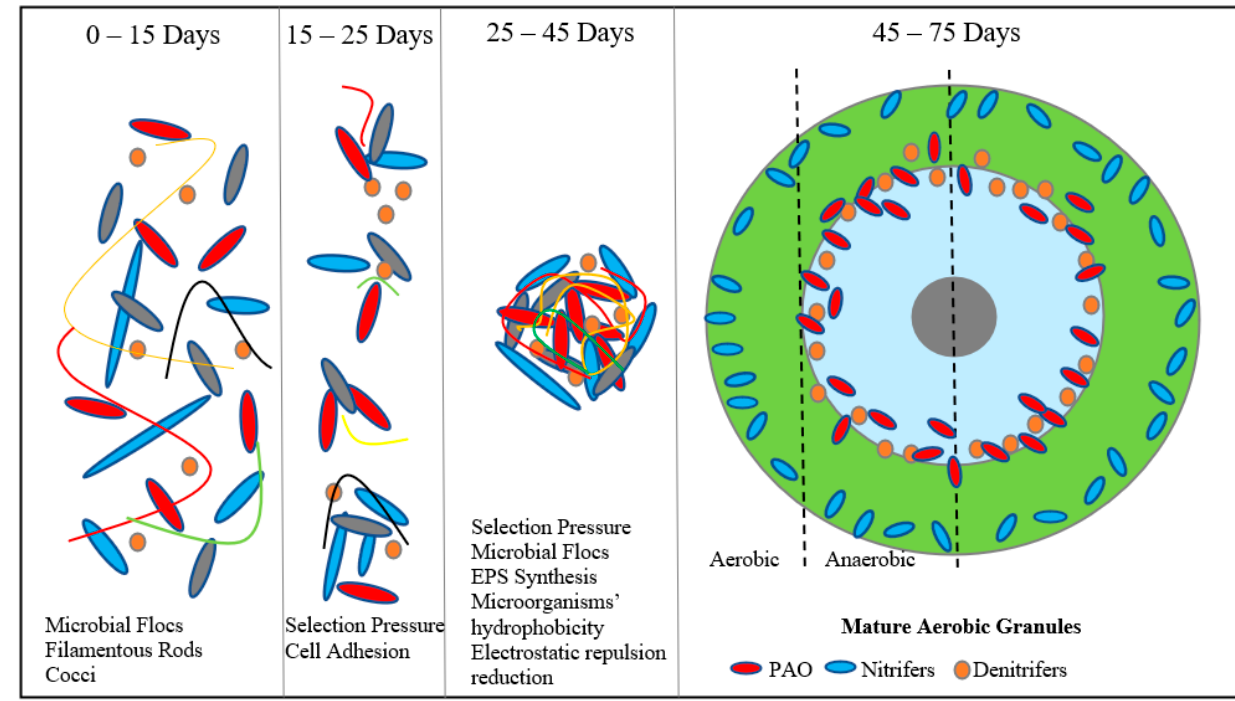
Figure 6. Illustrative chart of granulation process.